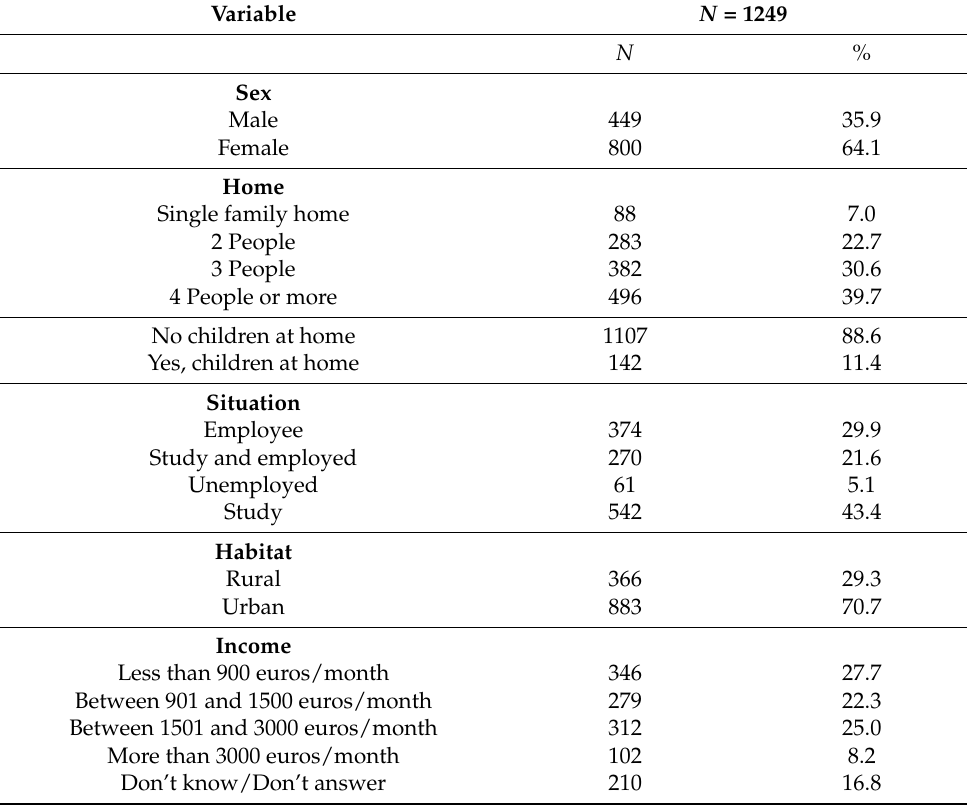
Table 1. Sociodemographic characteristics of the